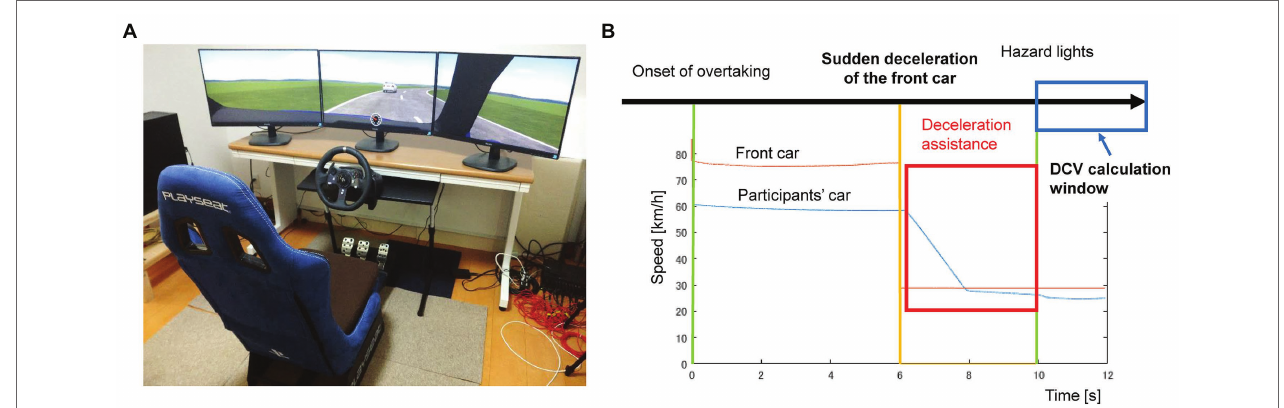
FIGURE 1 | The experimental devices (A) and the timeline of the trial (B)